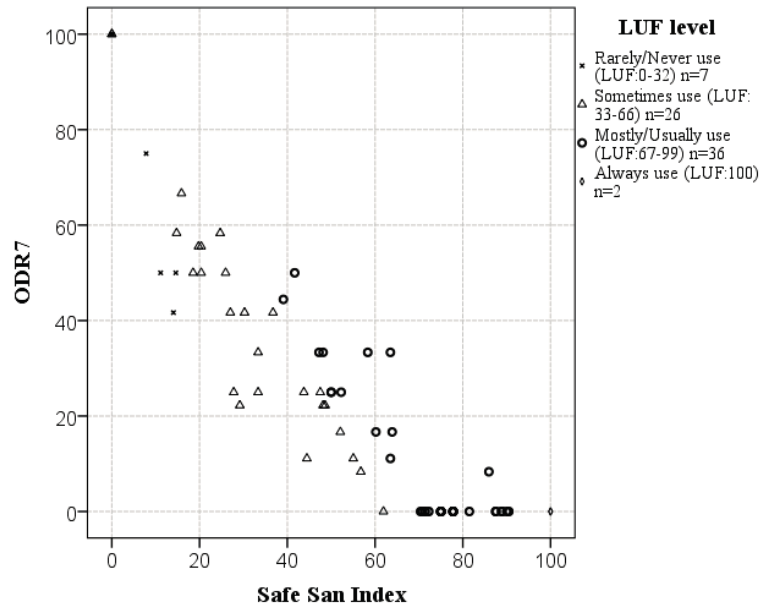
Figure 2. Extent of open defecation over the last 7 days (ODR7 score) of members of study households with a functioning latrine (n = 71), classified by LUF score, and plotted against their Safe San Index score (F1